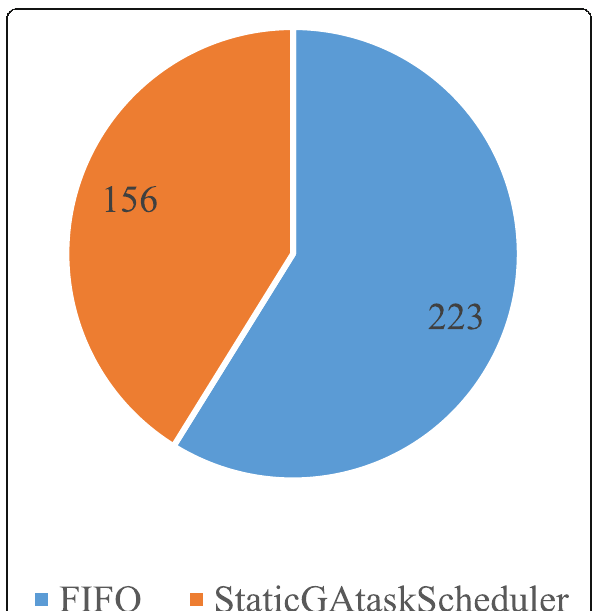
Fig. 4 Running time under two